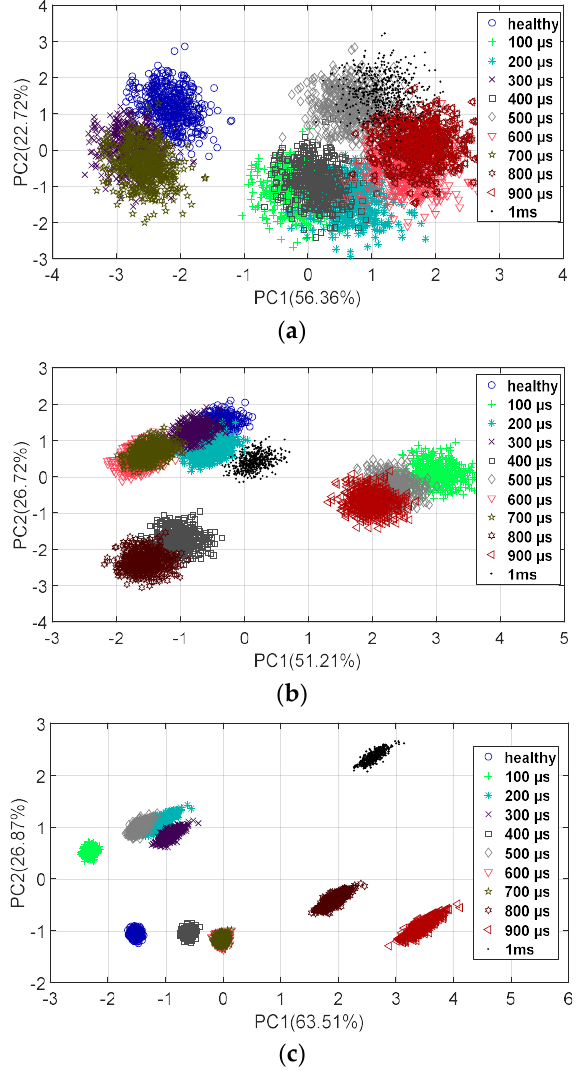
Figure 19. PCA results for 20 rad/s motor speed and SNR = 20 dB: ( a ) no load, ( b ) half rated load, and ( c ) full load.